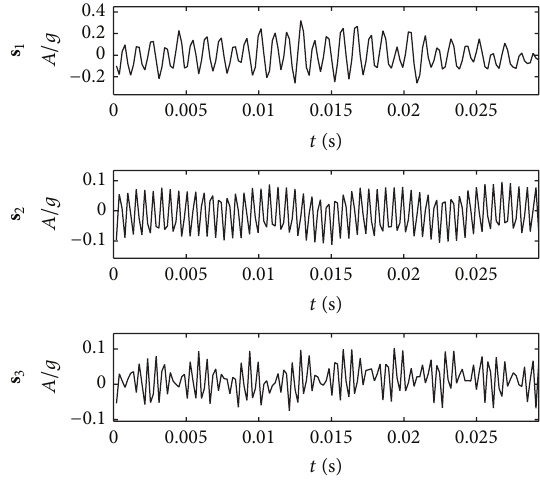
Figure 10: Waveforms of the source signals.